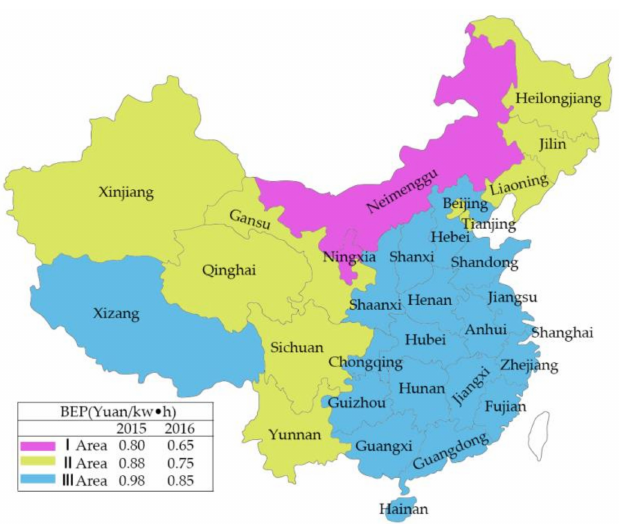
Figure A1. China’s photovoltaic benchmark electricity price